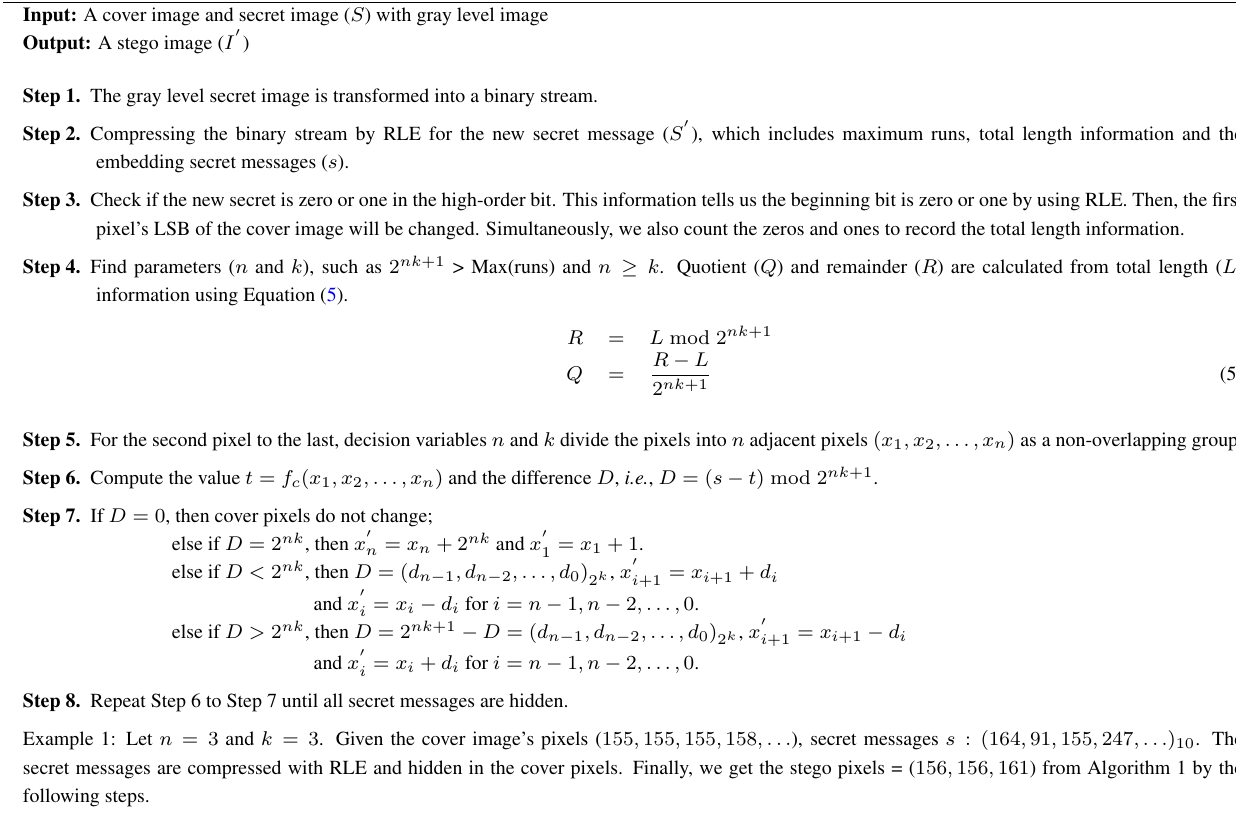
Algorithm 1 . The multi-bit data hiding scheme for compressing secret